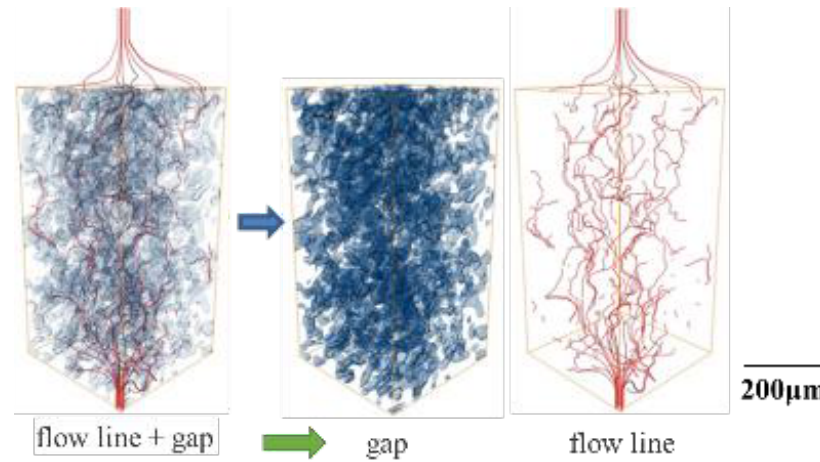
Figure 18. Seepage channel with shear.